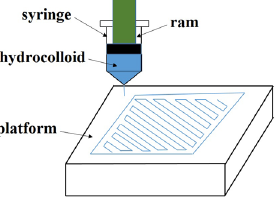
Fig. 1 Schematic diagram of the extrusion 3D printing